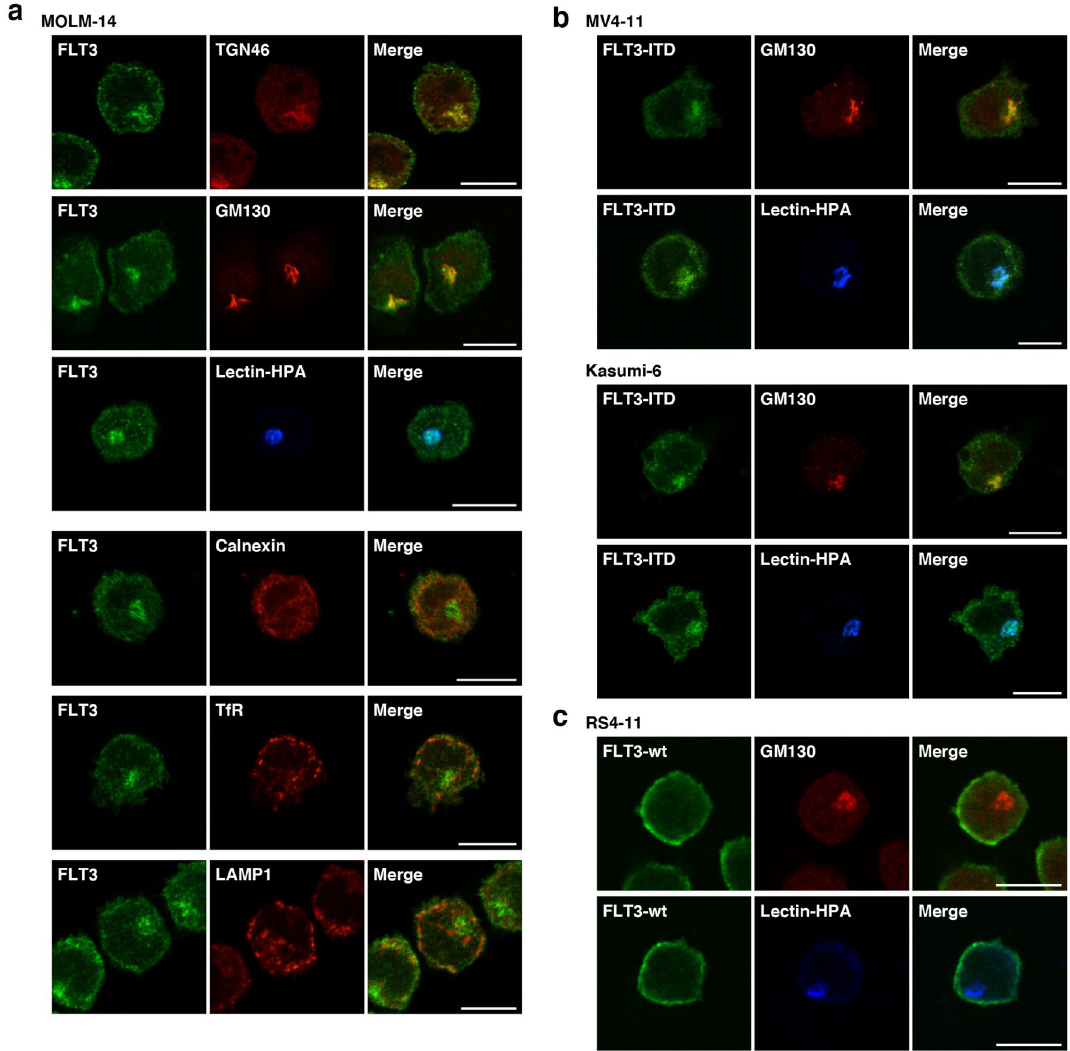
Figure 2. Endogenous FLT3-ITD localizes to the perinuclear Golgi region in AML cells. ( a – c ) MOLM-14 ( a ), MV4-11, Kasumi-6 ( b ), or RS4-11 cells ( c ) were stained for FLT3 (green) in conjunction with the indicated organelle markers (red or blue). TGN46 (Golgi marker, red), GM130 (Golgi marker, red); lectin-HPA (Golgi marker, blue); calnexin (ER marker, red); TfR (endosome marker, red); LAMP1 (lysosome marker, red). Bars, 10 µm. Note that FLT3-ITD accumulated in the Golgi region in AML as well as BFA to confirm the effect of blockade of ER export on FLT3 signaling. Our immunofluorescence assay on MOLM-14 cells showed that BFA/M-COPA treatment decreased FLT3 levels in the Golgi region within 8 h and greatly increased the co-localization of calnexin (ER marker) with FLT3 (Fig. 4a, see inset panels), con- firming that these inhibitors block biosynthetic protein transport from the ER to the Golgi apparatus. Next, we performed immunoblotting. As shown in Fig. 4b, in the presence of BFA/M-COPA, FLT3-ITD was retained in a high mannose form (see upper panels), confirming blockade of complex glycosylation in the Golgi appara- tus. Consistent with a previous report 4 , pFLT3 Y842 decreased with BFA/M-COPA treatment, indicating that the phosphorylation does not occur in the ER. On the other hand, pFLT3 Y591 was maintained in the ER (Fig. 4b, left, bottom panel). In MV4-11 and Kasumi-6 as well as MOLM-14, FLT3-ITD in the ER was unable to activate AKT and ERK (Fig. 4c; Suppl. Fig. 4a,b). Blockade of ER export, however, did not inhibit STAT5 activation through FLT3-ITD (Fig. 4b,c; Suppl. Fig. 4a,b). These results indicate that ER-retained FLT3-ITD activates STAT5 but not AKT and ERK. Next, we asked whether FLT3-ITD in the Golgi apparatus can activate AKT or ERK by using monensin, a blocker of Golgi export 21,22,33,38,39 . As shown in Fig. 4d, our immunofluorescence assay showed that FLT3 dis- tribution other than in the Golgi region was markedly decreased in MOLM-14 cells in the presence of 100 nM monensin for 8 h, confirming the expectation that the treatment blocks Golgi export of FLT3-ITD. Only the high-mannose form of the FLT3 bands was found in the presence of monensin (Fig. 4e, top panel). In the pres- ence of monensin, pFLT3 Y842 was decreased (Fig. 4e), whereas pFLT3 Y591 remained unchanged (Fig. 4e, bottom panel), suggesting that the treatment does not block all tyrosine phosphorylations in FLT3-ITD and that these